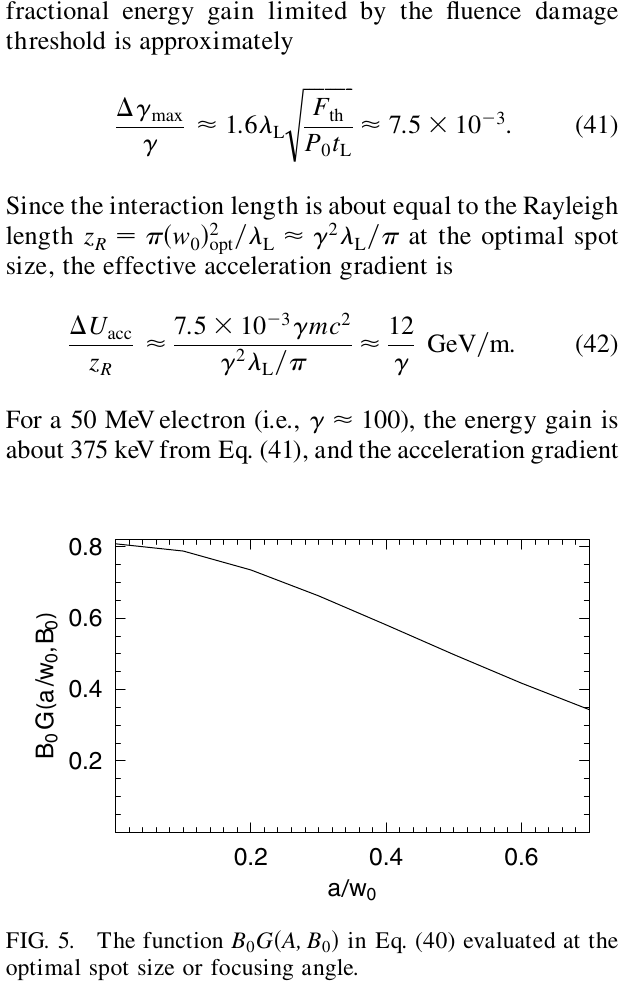
FIG. 5. The function B optimal spot size or focusing